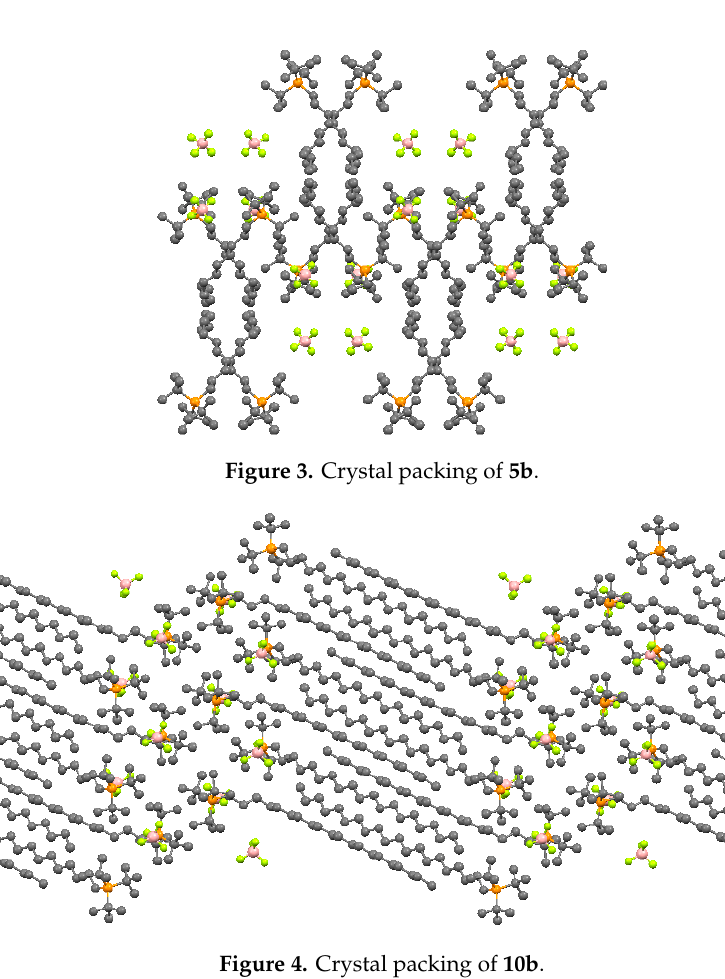
Figure 2. Crystal packing of 1a .